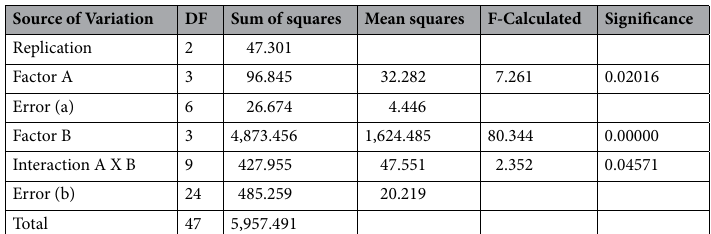
Table 11. Analysis of variance for effect of operating parameters on incorporation efficiency. Factors A and B combine horizontal & vertical clearance and forward speed, respectively.